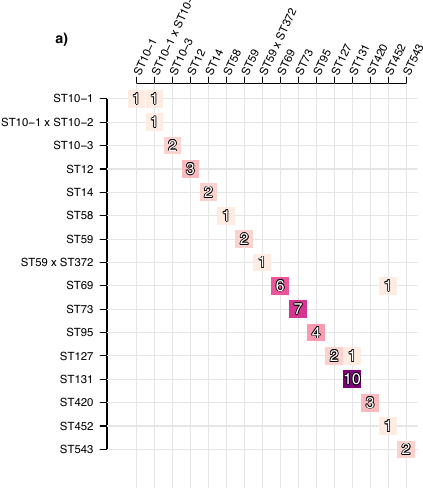
b Events for the caesarean section delivery cohort with infancy period excluded. Darker shades of purple denote more common events, the count of which is also indicatedbythe number containedwithinthe shaded boxes. Lineages shown were observed at least twice across the whole set of